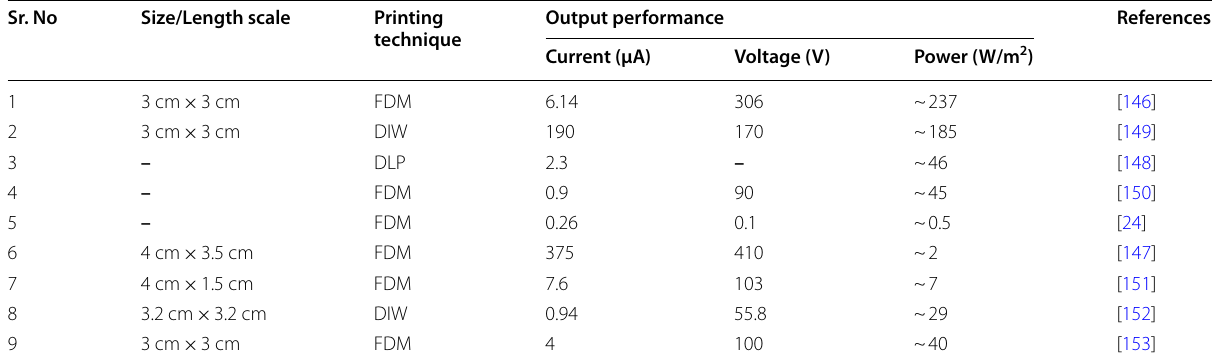
The references of the research papers cited in this table are provided in the Additional file 1